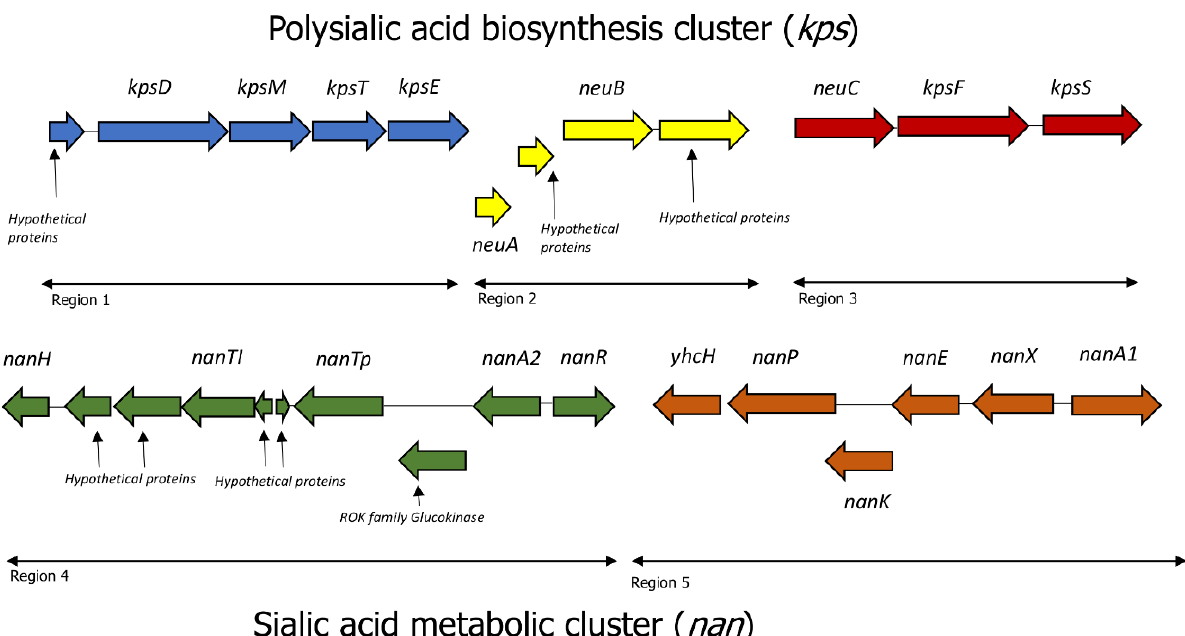
Figure 3. Aeromonas rivipollensis strain G87 organization gene clusters for capsular polysialic acids and an exogeneous sialic acid metabolic cluster. The kpsDMTE and kpsFS genes are required for capsulation (region 1, blue, and region 3, red). The kpsFS genes participate in the translocation of the polysaccharide. The precursors of polysialic acid biosynthesis are neuABC (region 2, yellow, and region 3, red). The nanARH with TRAP transporters in region 4, and nanTp-TI genes (green) are responsible for exogenous sialic acid, while the nanAXEKP and yhcH genes (orange) are responsible for the degradation or catabolism of salic